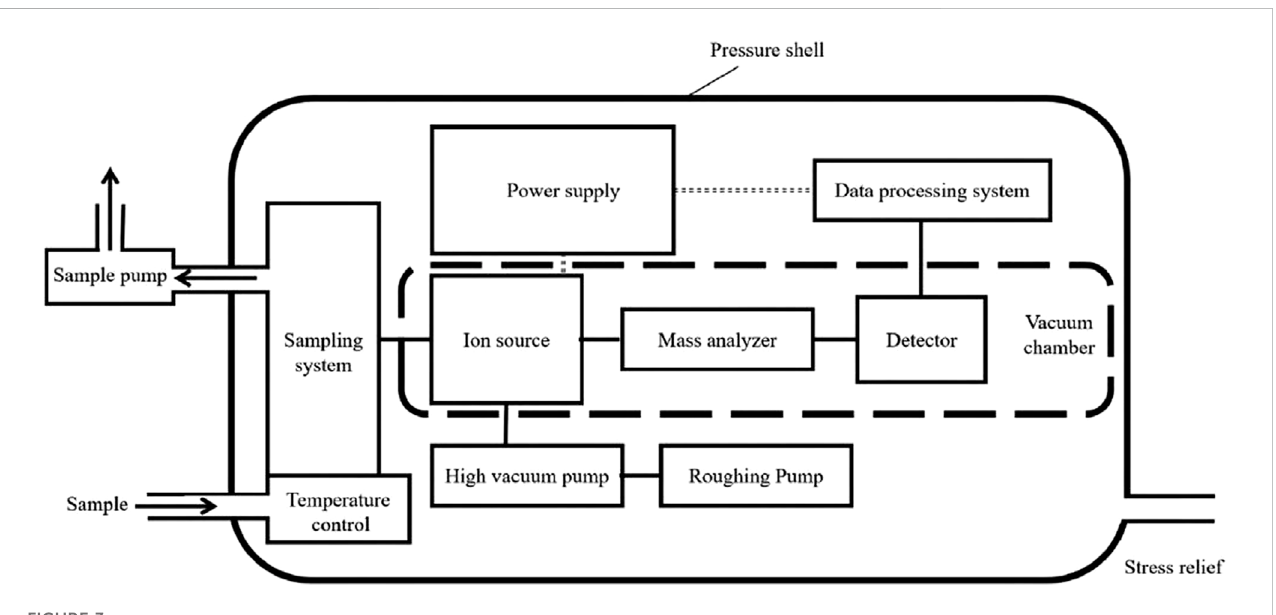
FIGURE 3 Schematic diagram of underwater mass spectrometry system (Gao et al.,